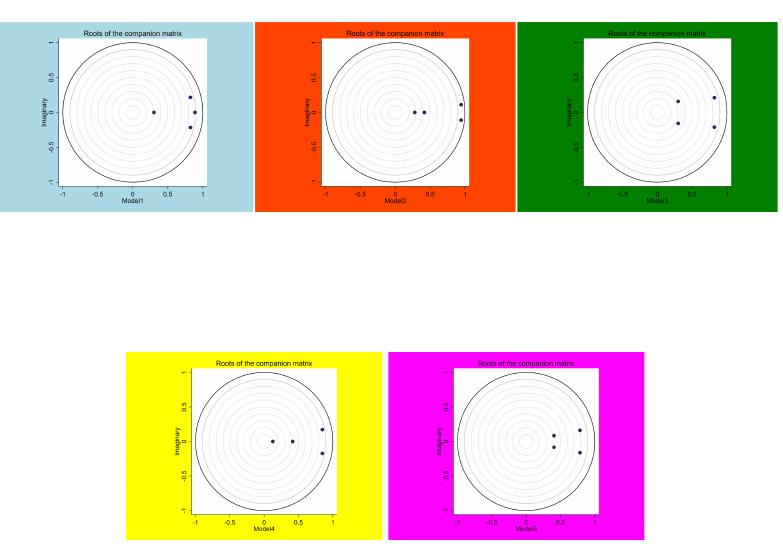
Figure 11. Stability test results for Model 1 − 5. All four variables (the four black dots) fall within the unit circle, which indicates that these models are